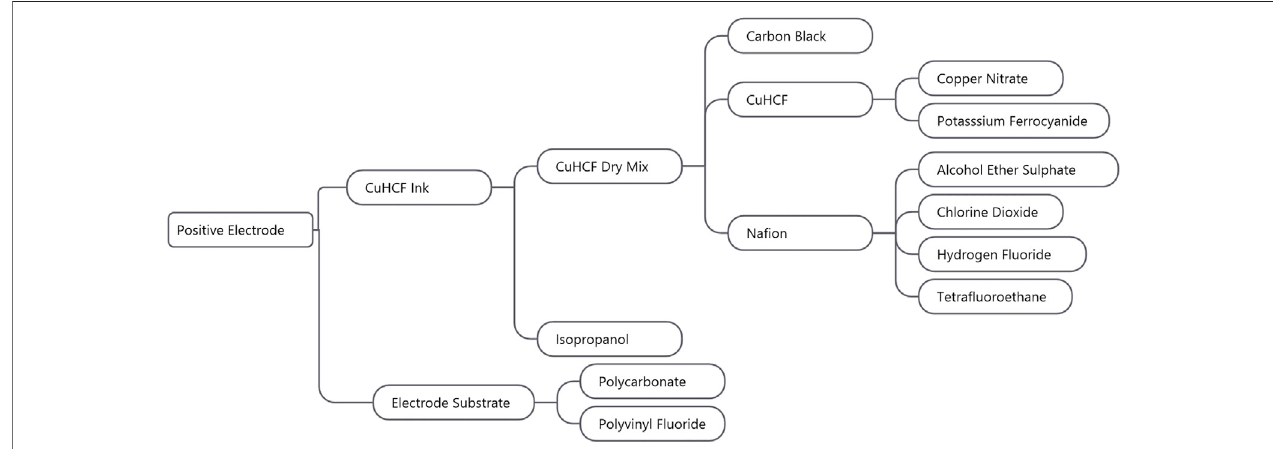
FIGURE 4 | Production fl ow for the positive electrode redrawn from